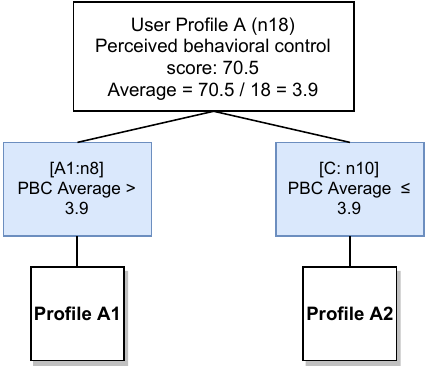
Figure 10. User profiling decision tree applied to respondent number